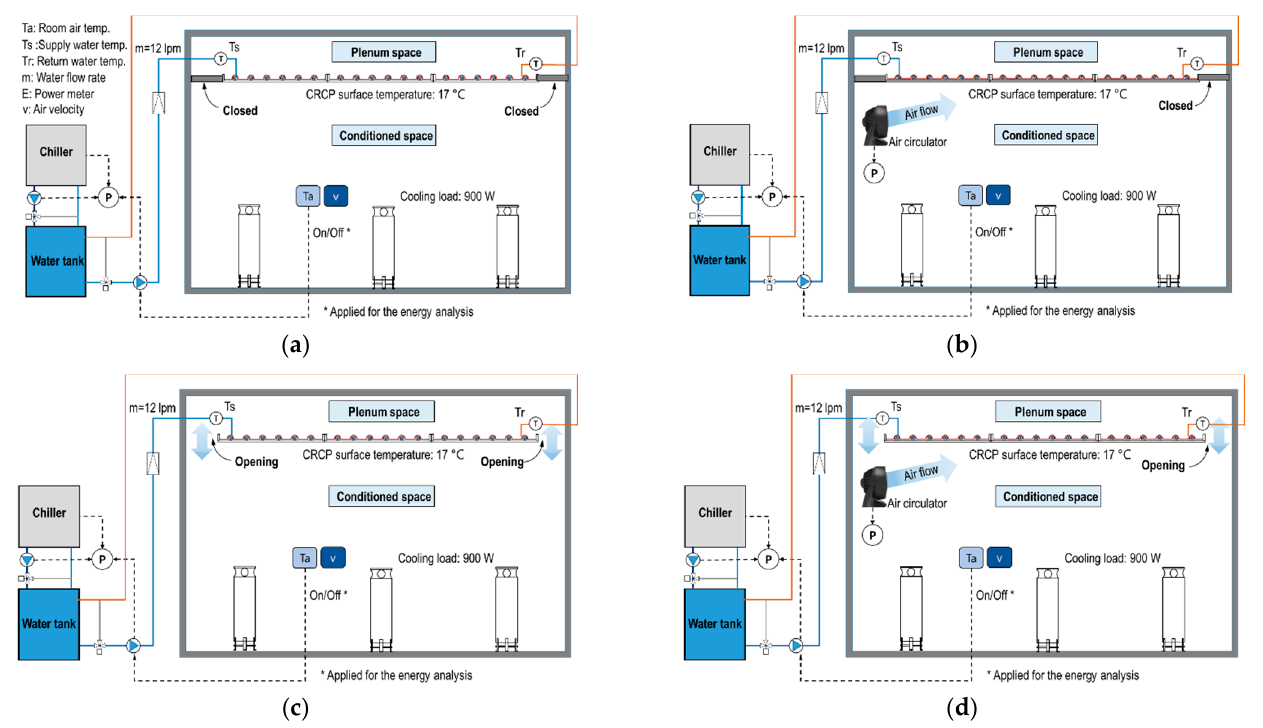
Figure 3. Evaluation cases: ( a ) closed-type CRCPs; ( b ) closed-type CRCPs with air circulators; ( c ) open-type CRCPs; ( d ) open-type CRCPs with air circulators.